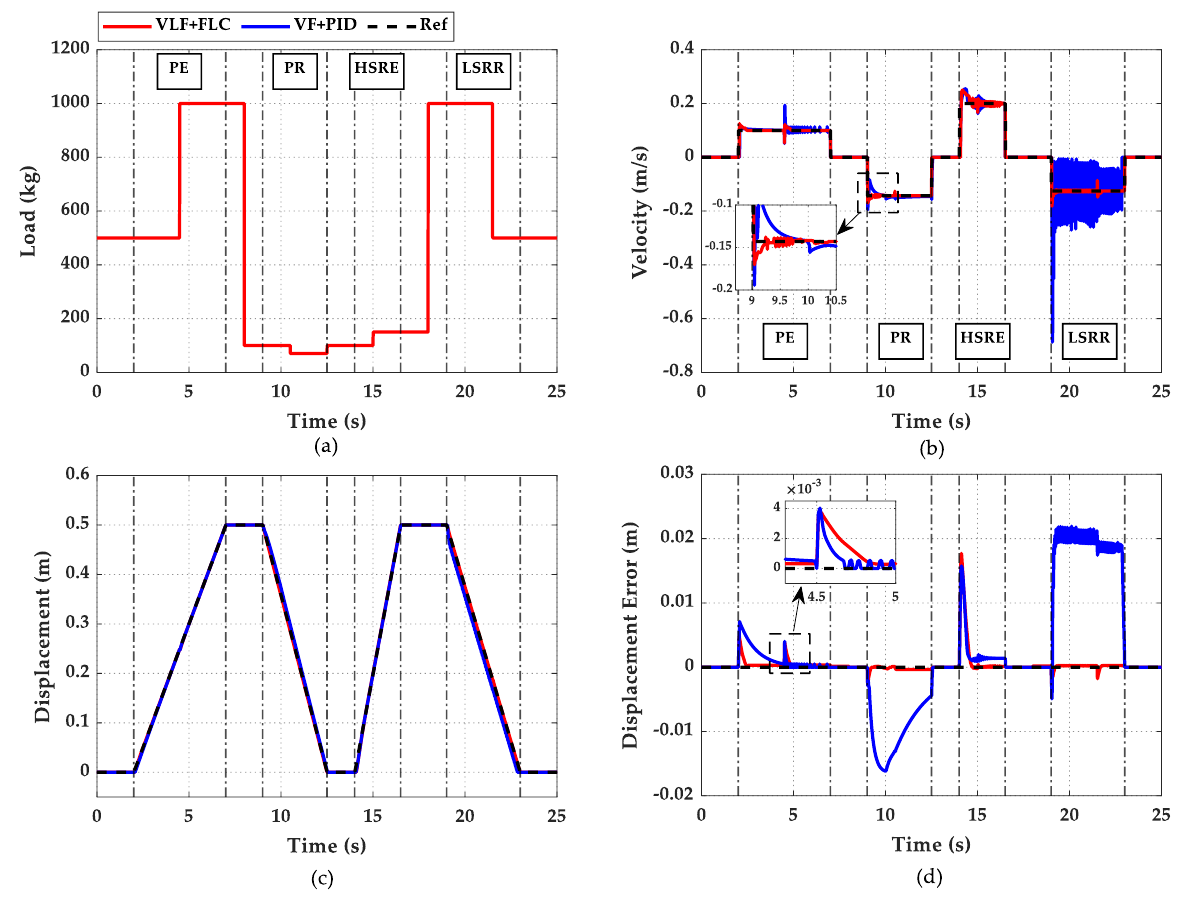
Figure 12. Comparison of the tracking precision of both methods under variable load. ( a ) The variable load applied to the cylinder, ( b ) the velocity, ( c ) the displacement, and ( d ) the displacement error.